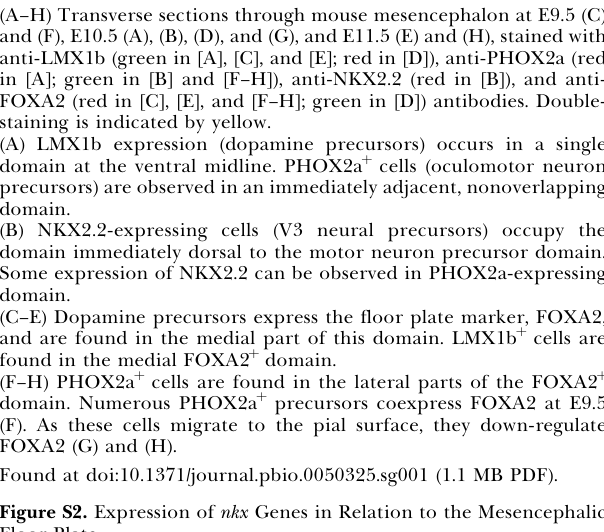
Figure S1. Expression of Transcription Factors in Ventral Midbrain Progenitors (A–H) Transverse sections through mouse mesencephalon at E9.5 (C) and (F), E10.5 (A), (B), (D), and (G), and E11.5 (E) and (H), stained with anti-LMX1b (green in [A], [C], and [E]; red in [D]), anti-PHOX2a (red in [A]; green in [B] and [F–H]), anti-NKX2.2 (red in [B]), and anti- FOXA2 (red in [C], [E], and [F–H]; green in [D]) antibodies. Double- staining is indicated by yellow. (A) LMX1b expression (dopamine precursors) occurs in a single domain at the ventral midline. PHOX2a þ cells (oculomotor neuron precursors) are observed in an immediately adjacent, nonoverlapping domain. (B) NKX2.2-expressing cells (V3 neural precursors) occupy the domain immediately dorsal to the motor neuron precursor domain. Some expression of NKX2.2 can be observed in PHOX2a-expressing domain. (C–E) Dopamine precursors express the floor plate marker, FOXA2, and are found in the medial part of this domain. LMX1b þ cells are found in the medial FOXA2 þ domain. (F–H) PHOX2a þ cells are found in the lateral parts of the FOXA2 þ domain. Numerous PHOX2a þ precursors coexpress FOXA2 at E9.5 (F). As these cells migrate to the pial surface, they down-regulate FOXA2 (G) and (H). Figure S2. Expression of nkx Genes in Relation to the Mesencephalic Floor Plate Transverse sections through mouse mesencephalon at E9.5 (B), E10.5 (A) and (C), and E11.5 (D), stained with anti-FOXA2 (green in [A]; red in [B–D]), anti-NKX2.2 (red in [A]), anti-NKX6.1 (red in [B–D]) antibodies. The NKX2.2-expressing cells in (A) flank the FOXA2 þ floor plate in the midbrain, just as they do in the developing spinal cord. Found at doi:10.1371/journal.pbio.0050325.sg002 (695 KB PDF). Figure S3. Expression of Transcription Factors in Neurons of the Ventrolateral Fetal Midbrain (A) GATA3 expression is observed in a subset of neurons differ- entiating in the NKX6.1 domain E10.5. (B and C) At E11.5, GATA3 þ neurons are located immediately adjacent to the NKX6.1 þ motoneurons (B). Like GATA3, LIM1/2 is expressed in neurons immediately adjacent to the NKX6.1-expressing motor neurons (C). In (B) and (C), NKX6.1 expression is lost as progenitors differentiate to GATA3- and LIM1/2-positive neurons. (D) At E12.5, motor neurons are identified by PHOX2a expression, and more lateral neurons by LIM1/2 expression. LIM1/2 expression at E12.5 expands dramatically, compared to E11.5 (C). Found at doi:10.1371/journal.pbio.0050325.sg003 (461 KB PDF). Figure S4. Gliosis in foxa2 þ / (cid:2) Mice (A) Widespread gliosis is seen in the ventral midbrain of foxa2 þ / (cid:2) mice (TH, green; GFAP, red). (B and C) Increased density of glia is easily seen in the red nucleus of wild-type (B) and foxa2 þ / (cid:2) mice (C). (D) Quantitation of glia in wild-type and foxa2 þ / (cid:2) dopaminergic system throughout the VTA, the SN pars compacta and reticulata, and red nucleus. Figure S5. Severe Asymmetric Loss of Nigral Dopamine Neurons in One Mouse Coronal sections through the midbrain of a wild-type (A), (C), (E), (G), and (I) and a foxa2 þ / (cid:2) (B), (D), (F), (H), and (J) mouse at the indicated level. There is an almost complete loss of nigral dopamine neurons on